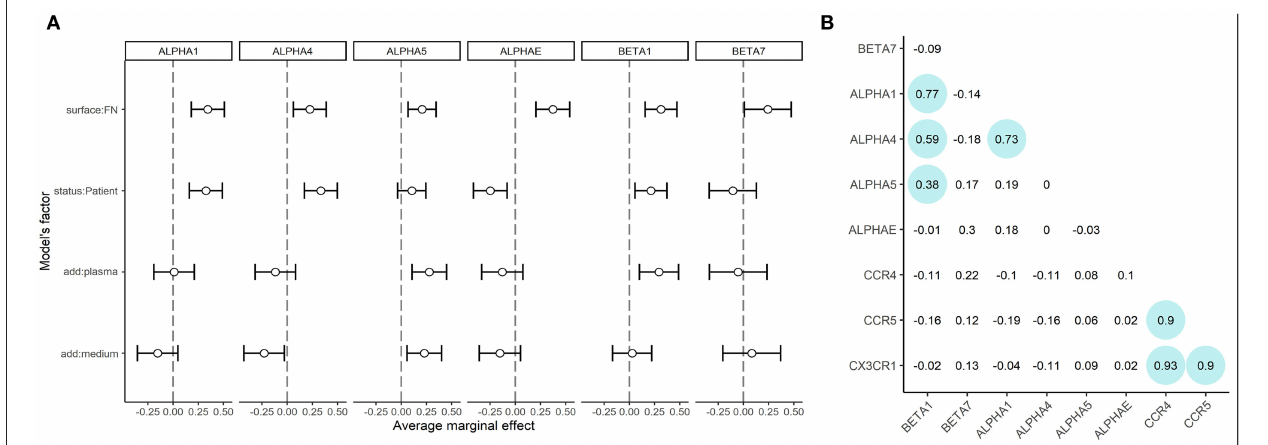
FIGURE 3 | mRNA expression of integrin subunits and in CTLs (A) Integrin mRNA expression. Average marginal effects (AME) for linear generalized model, where zero states are CTLs from healthy donors, seeded on plastic without soluble ligands from plasma or conditioned medium from atherosclerotic plaques. The changed (model) factors are: (1) the status of the individual: donor/patient with atherosclerosis, (2) use of fibronectin in coating; (3) use of conditioned medium from atherosclerotic plaque in coating; (4) use of plasma from patients with atherosclerosis in coating. The dependent variable is the expression of integrins beta1, beta7, alpha1, alpha4, alpha5 or alphaE mRNAs. ITGB1, ITGB7, ITGA1, ITGA4, ITGA5, and ITGAE are upregulated (dependent, p < 0.05) in the presence of fibronectin . ITGB1, ITGA1, ITGA4 are upregulated (dependent, p < 0.05) in patients compared to healthy donors. ITGAE is downregulated (dependent, p < 0.05) in patients compared to healthy donors. ITGB1 and ITGA5 are upregulated (dependent, p < 0.05) in the presence of plasma. ITGA5 is upregulated (dependent, p < 0.05) and ITGA4 are downregulated (dependent, p < 0.05) in the presence of a conditioned medium from atherosclerotic plaque. (B) Spearman coefficients of correlation for mRNA expression data. The significant correlations ( p < 0.05) are outlined in circles. A strong positive correlation is observed between CCR5, CCR4, and CX3CR1 mRNAs expression. The mRNAs expression of ITGB1, ITGA1, and ITGA4 also show positive correlation, additionally, ITGB1 shows a weaker correlation with ITGA5